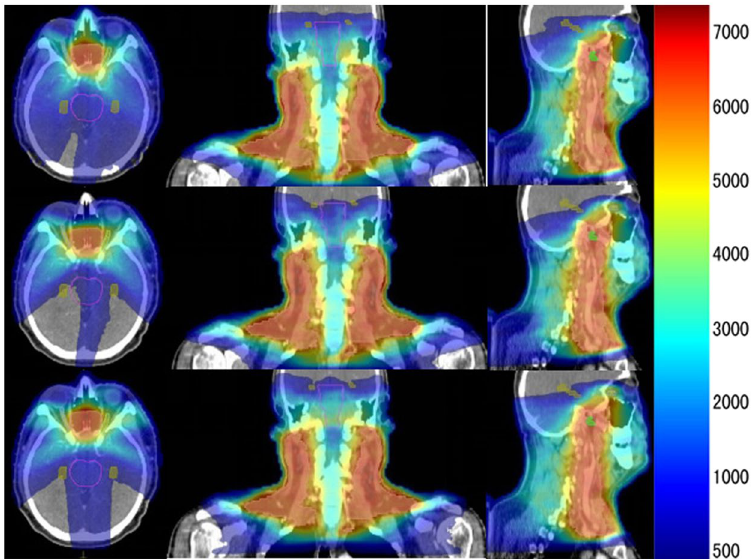
Figure 2. Dose distribution in selected transversal, coronal and sagittal planes for a patient. The first row was from the conventional VMAT plans, the second row from HS-VMAT plans, the third row from HS-dMLC plans.